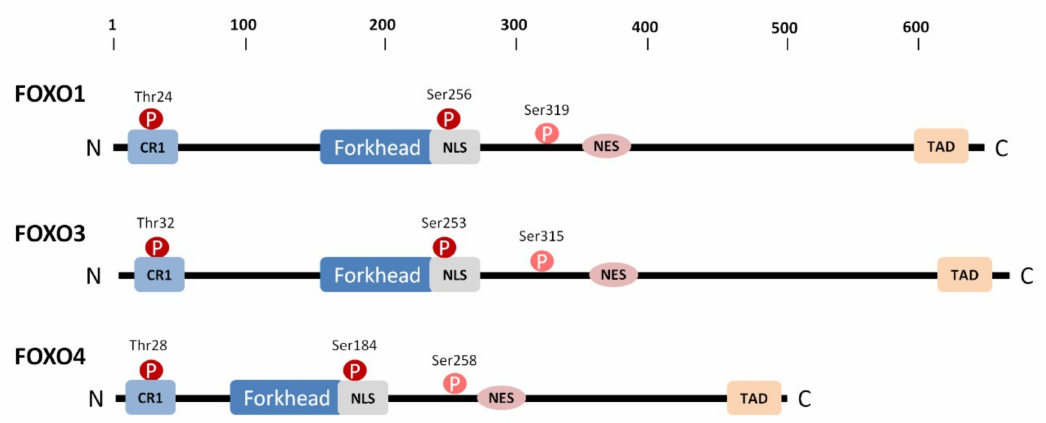
Figure 1. Domain structure of FOXO proteins. The positions of PKB / Akt phosphorylation sites are indicated by circles. The first two PKB / Akt phosphorylation sites are also binding motifs for the sca ff olding 14-3-3 protein. CR1, conserved region 1; NLS, nuclear localization signal; NES, nuclear export signal; TAD (CR3), transactivation